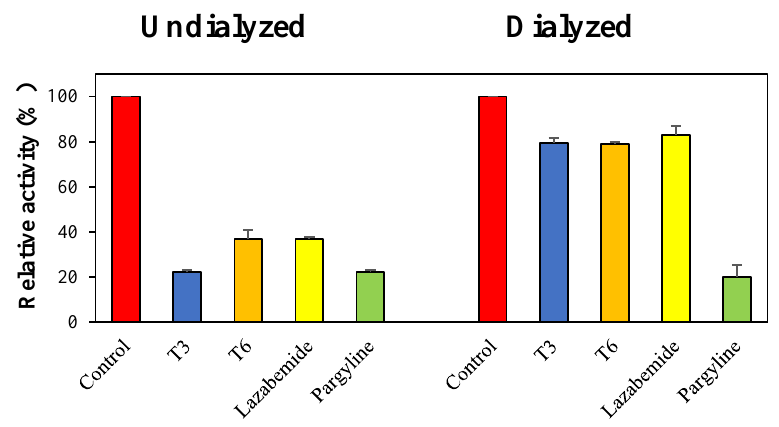
Figure 3. Recoveries of MAO-B inhibitions by T3 and T6 by dialysis.